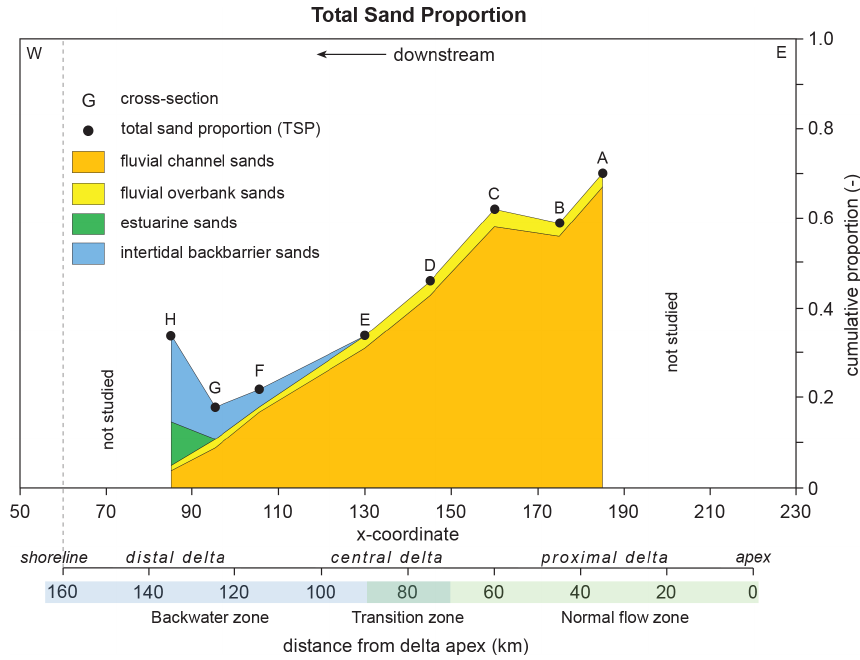
Figure 7. Diagram showing the contributors to the total sand proportion for each cross section. The total sand proportion is the sum of fluvial channel-belt sands, coarse-grained overbank deposits in crevasse splays and lake deposits (cf. Bos and Stouthamer, 2011), estuarine sands (notably bay–head delta deposits; Hijma et al., 2009), and sandy back-barrier intertidal deposits. In the upstream delta, most sand is stored in fluvial channel-belt sand bodies. In contrast, most sand in the downstream delta is estuarine and intertidal in nature.